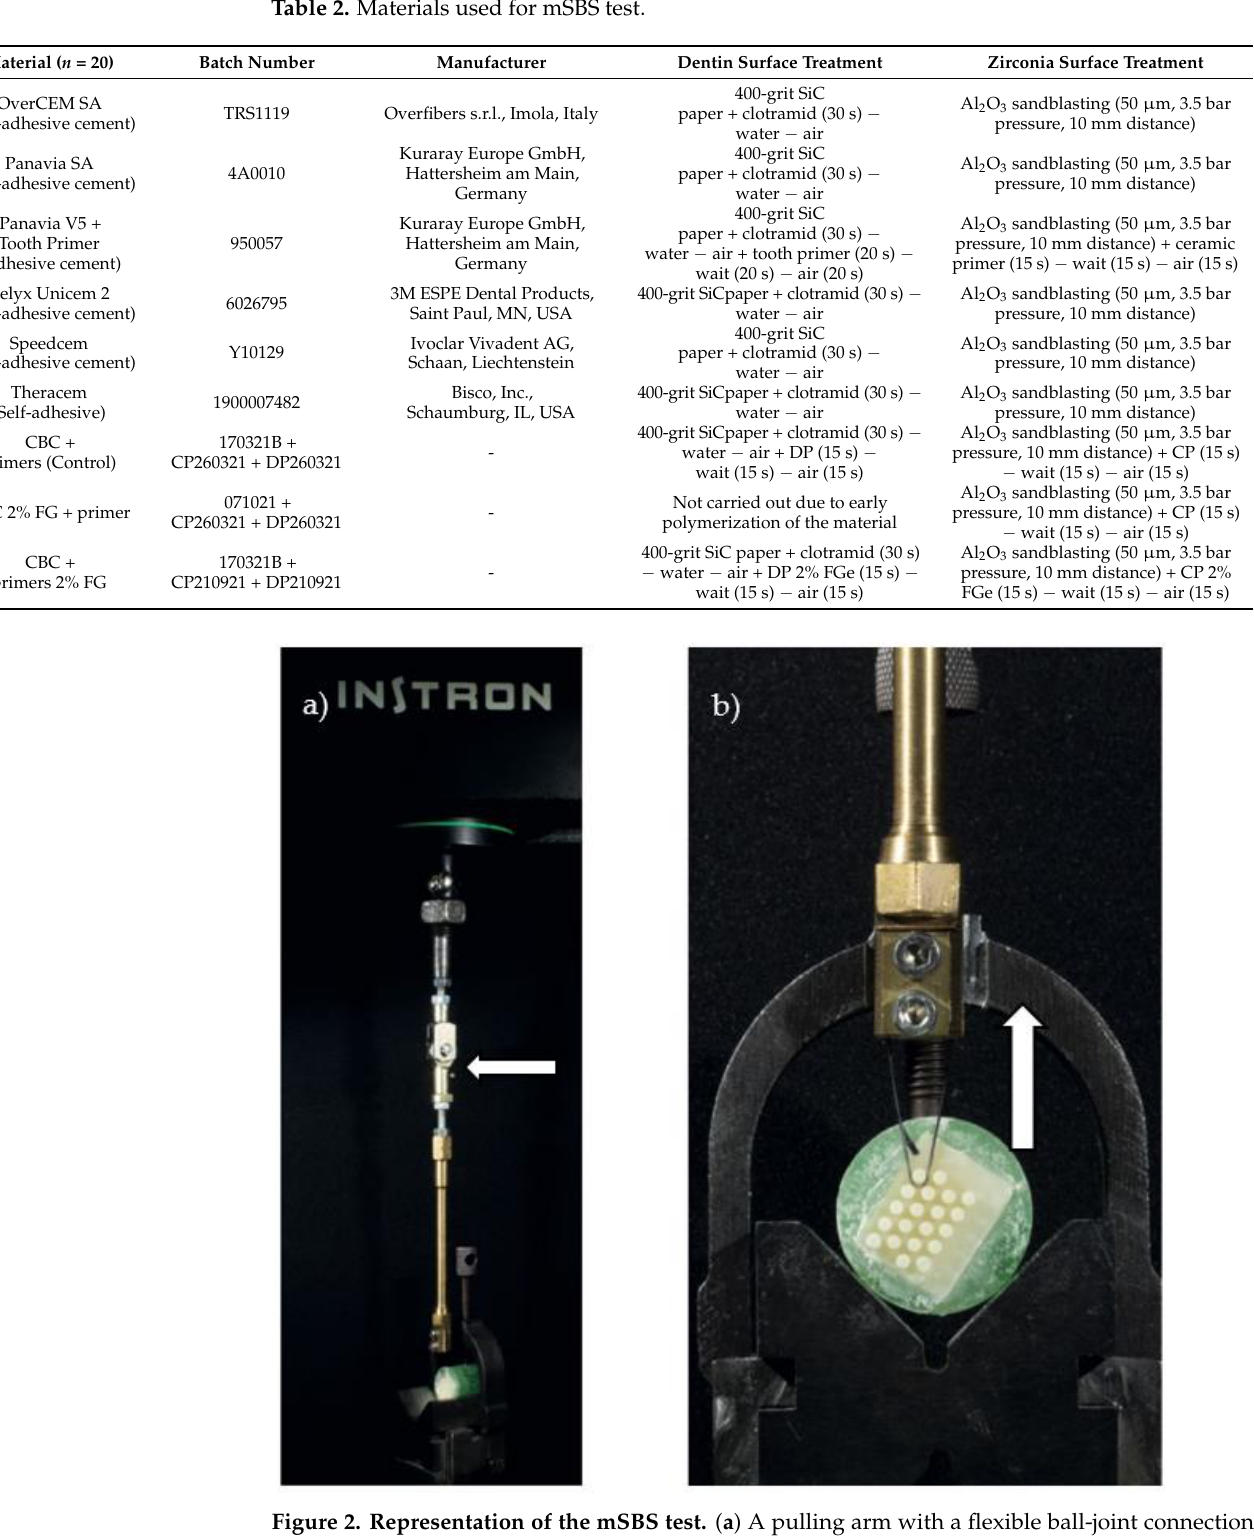
Table 2. Materials used for mSBS test.